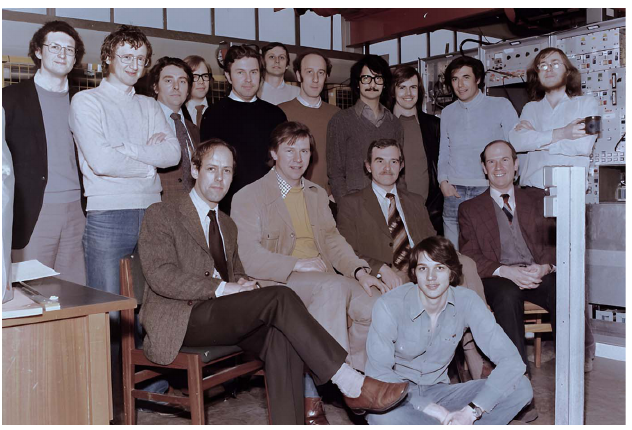
Figure 1 A photograph of the NINA Synchrotron Radiation Facility team taken a few hours before the final switch off of NINA on 31 March 1977. From left to right: Pat Ridley, Iggy McGovern, Bill Smith, Tony Bourdillon, John West, John Beaumont, John Morton, Ian Munro, Paul Brint, Samar Hasnain, Jeff Worgan, Robert Pettifer, Tom Short, Joan Bordas, Ken Lea and Tony